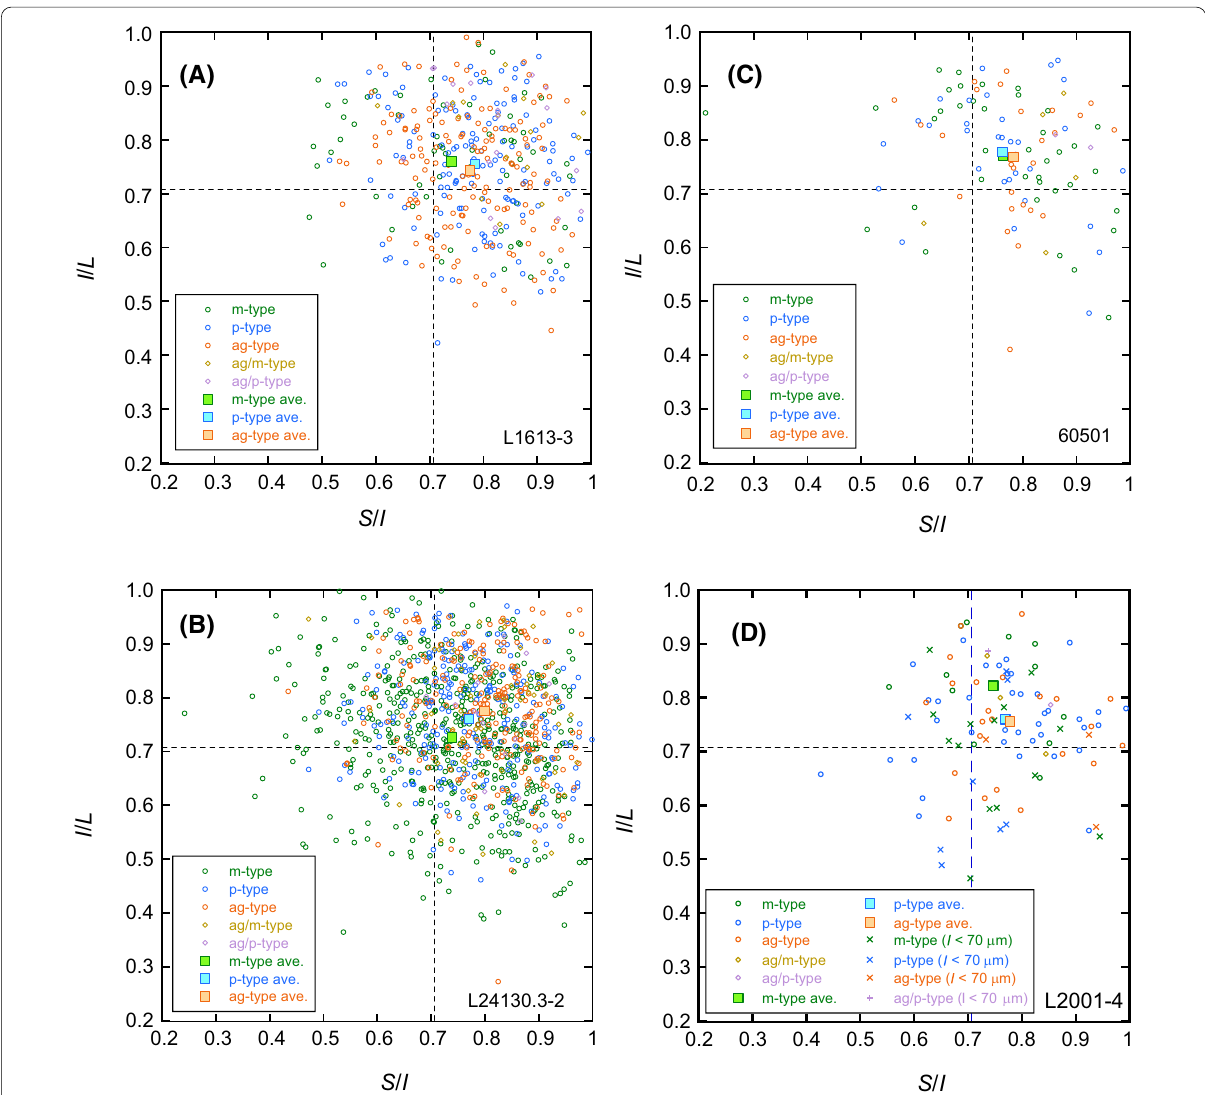
Fig. 2 Zingg diagrams of lunar regolith particles showing typical particle shape distributions. A L1613-3 from Mare Fecunditatis (127–200 µm, mature or submature, and N 389). B L24130.3–2 from Mare Crisium (74–95 µm, immature, and N = (75–105 µm, mature, and N 104). D L2001-4 from Apollonius Highlands (200–450 µm, mature or sub mature, and N = in the second peak of the particle size histogram ( I < 70 µm). L , I, and S are the longest, intermediate, and shortest lengths of three-axial lengths of a particle, respectively. The dotted lines show the 2D silver